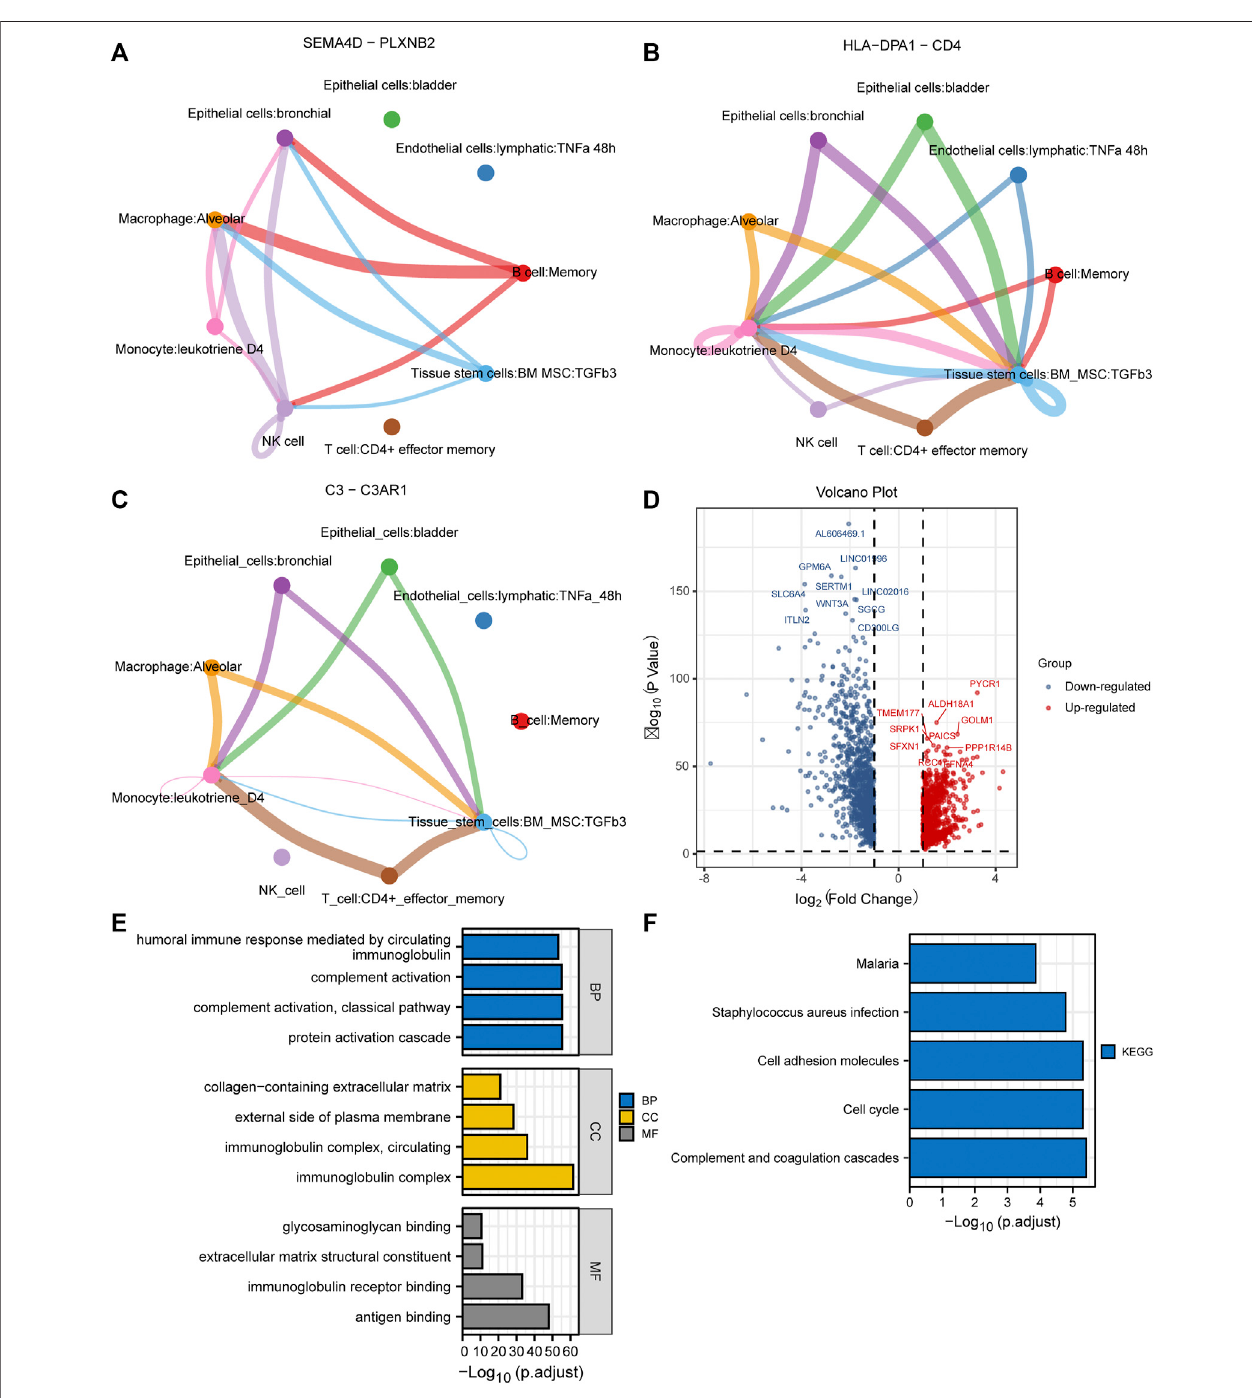
FIGURE 2 | Cell-cell communication network and identi fi cation of DEGs in TCGA cohort. (A – C) Cell-cell communication network identi fi ed that SEMA4D — PLXNB2, HLA − DPA1 — CD4, and C3 — C3AR1 play crucial roles in the communication network; (D) The volcano plot to show the up-regulated and down- regulated DEGs in TCGA cohort; (E,F) GO and KEGG enrichment analysis of the identi fi ed DEGs. DEGs, differentially expressed genes; TCGA, The Cancer Genome Atlas; GO, Gene Ontology; KEGG, Kyoto Encyclopedia of Genes and Genomes.